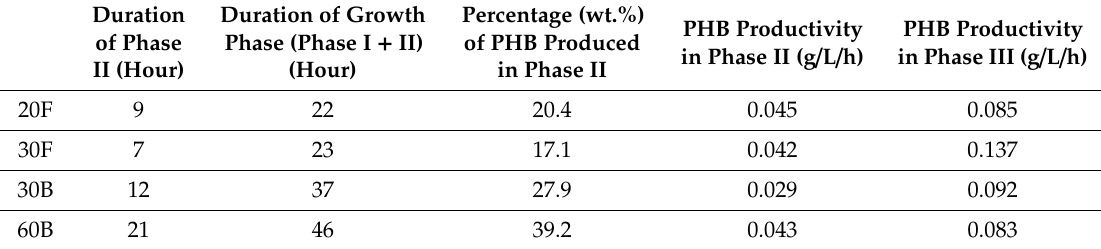
Table 3. Duration of Phase II and growth phase, percentage of total PHB produced in Phase II, PHB